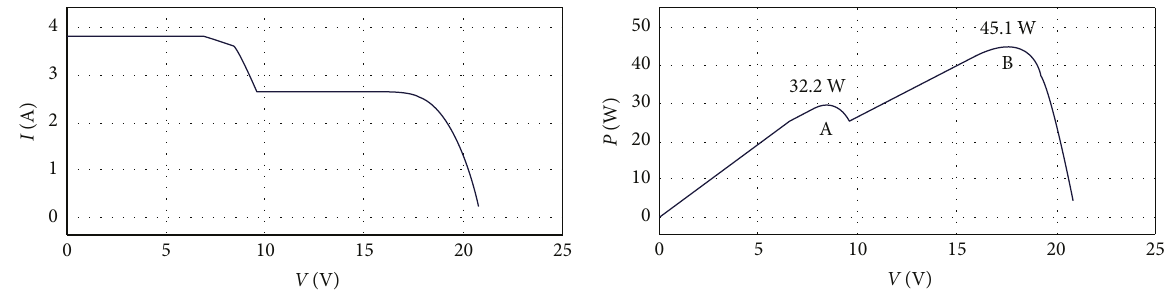
Figure 12: I ‐ V and P ‐ V characteristics of the PV panel under nonuniform irradiation.